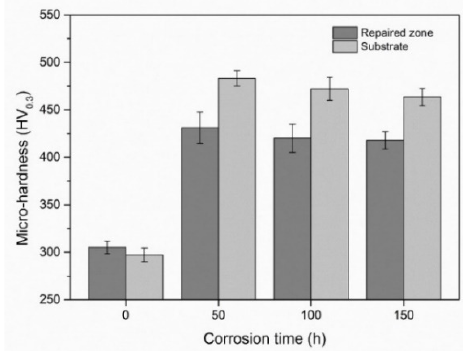
Figure 9. Micro-hardness variation of the repaired Inconel 718 alloy specimen with different exposure time to the molten salt at 650 °C.